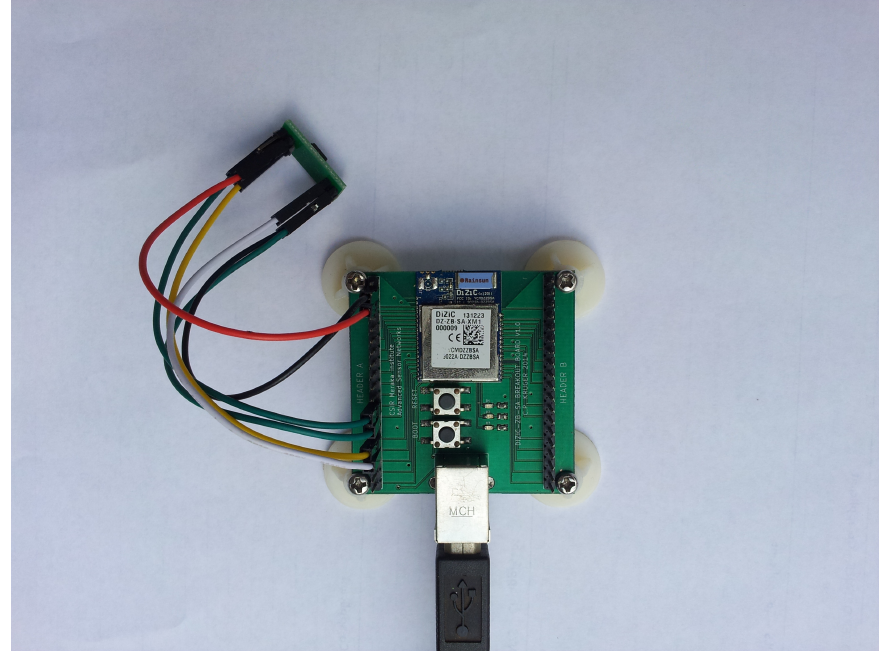
Figure 2. The rapidly prototyped Council for Scientific and Industrial Research (CSIR) Internet of Things node.